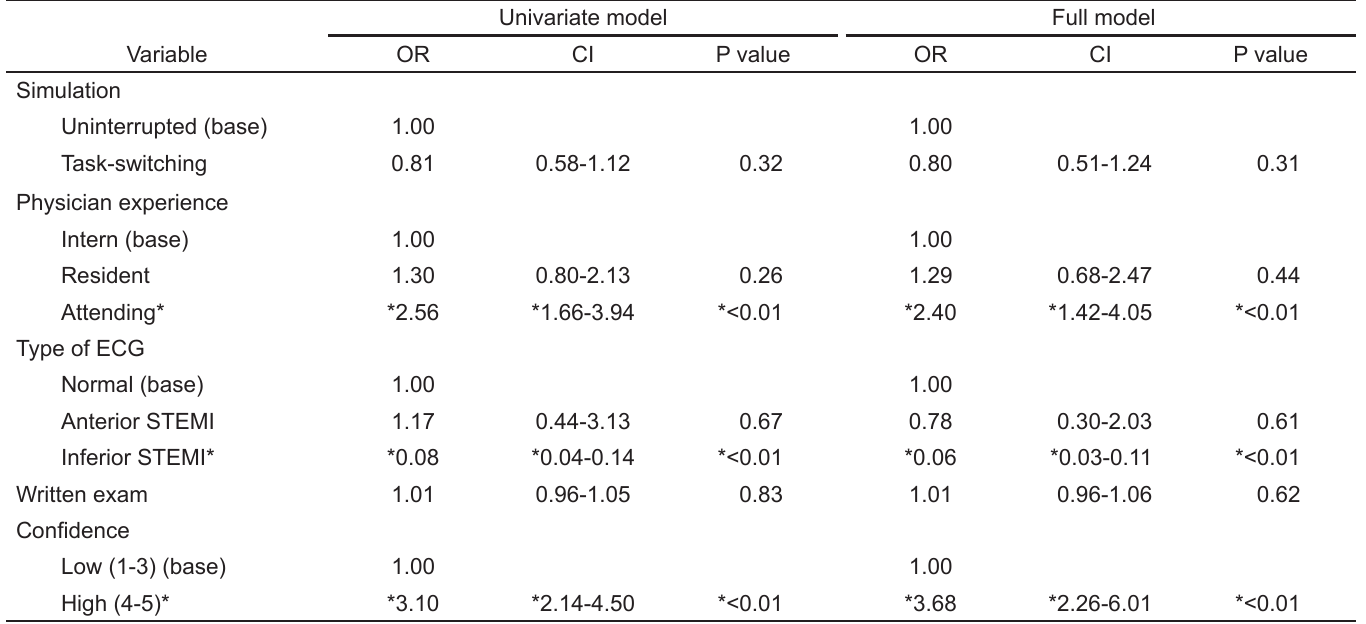
Table 2. Generalized estimating equations logistic regression (univariate and full model) for factors associated with correct ECG interpretation for STEMI. Low confidence was defined as a self-reported Likert score of 1-3, and high confidence was defined as a self- reported Likert score of